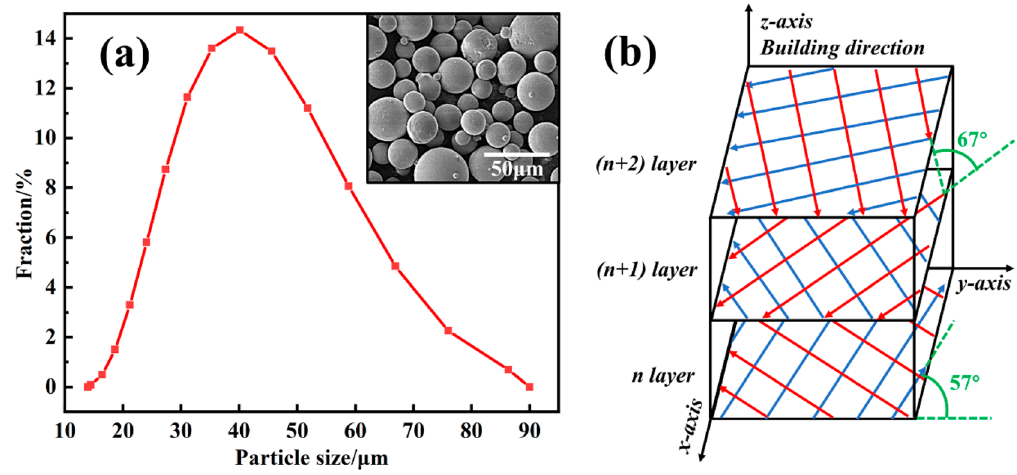
Figure 1. Morphology and particle size distribution of the powder ( a ) and schematic diagram of printing and scanning ( b ).